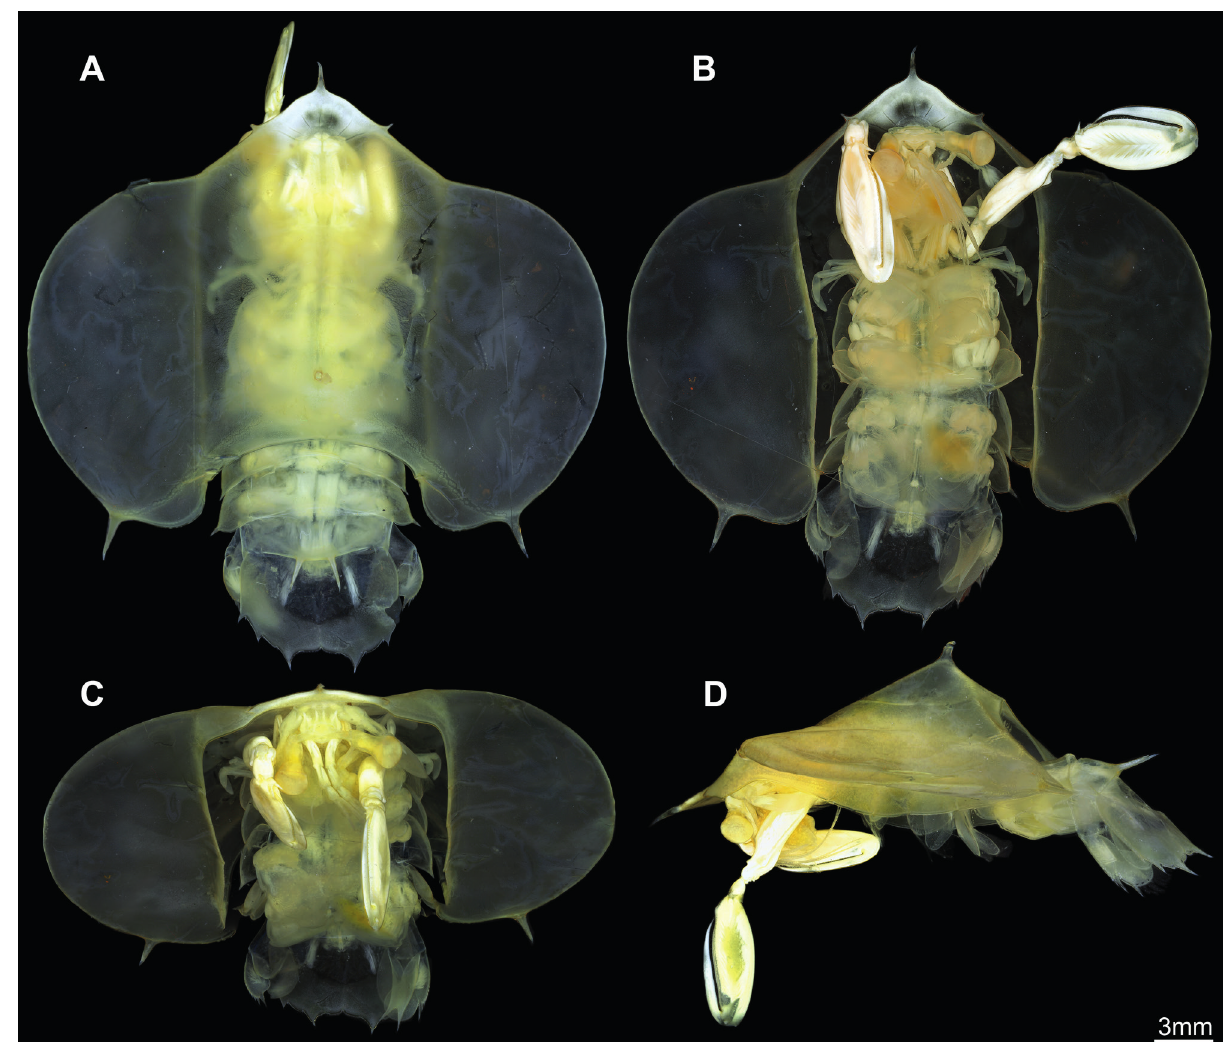
Figure 5. New morphotype 3, “flying saucer”; ZMUC-CRU-8666. A. Dorsal view. B. Ventral view. C. Antero-ventral view. D. Lateral